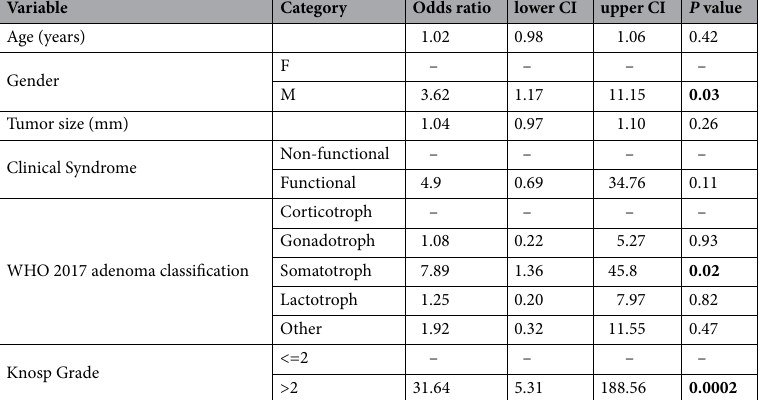
Table 2. Intraoperative medial wall invasion. Multivariate analysis of intraoperative evaluation of invasion of the medial wall of the cavernous sinus to identify variables that influence invasion. Odds ratio, Confidence Intervals and p values area